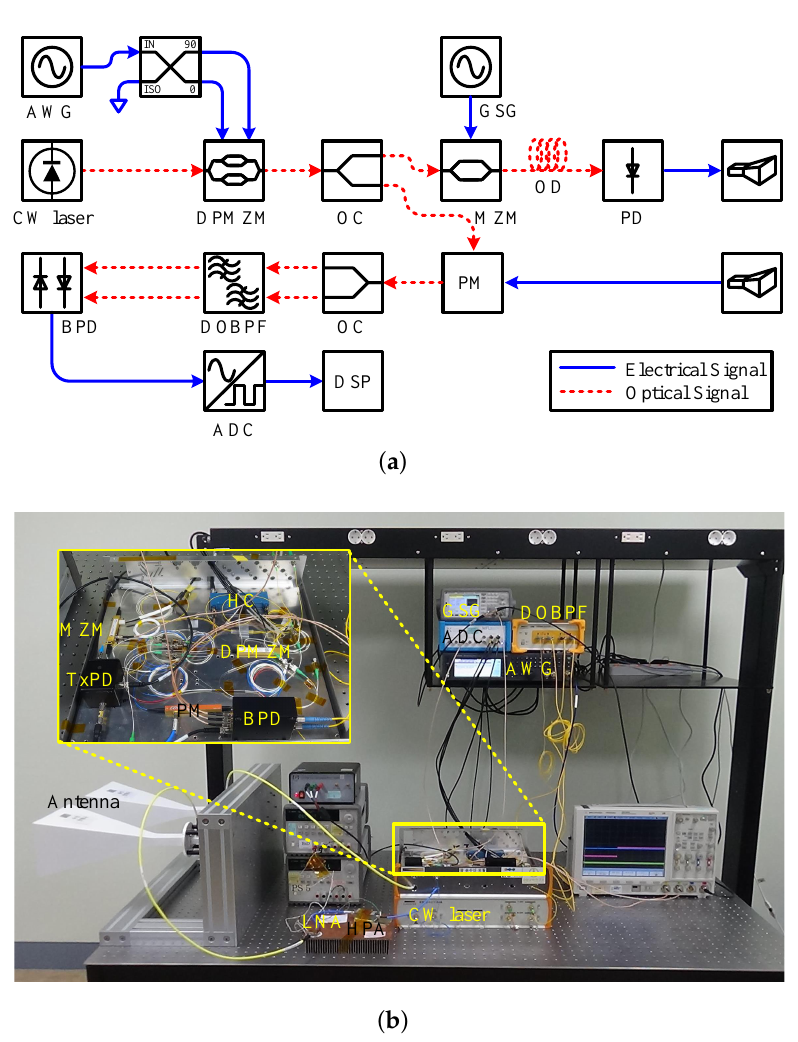
Figure 4. The prototype of the proposed photonic-based pulsed radar architecture for conducting the indoor experiment. ( a ) Configuration of the proposed radar architecture for indoor experiment. ( b ) Prototype implementation of the proposed radar architecture. HC: Hybrid coupler, TxPD: Transmit photodetector, HPA: High power amplifier, OD: Optical